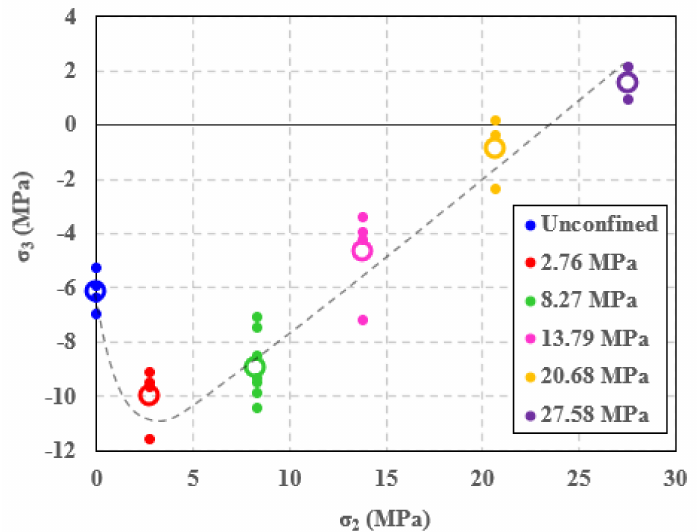
Figure 7. Intermediate and minimum principal stresses at failure for a series of confined, flattened Brazilian disks on sandstone. Average values at each confining stress, including unconfined, are represented by an open point. The dashed line represents the best fit failure